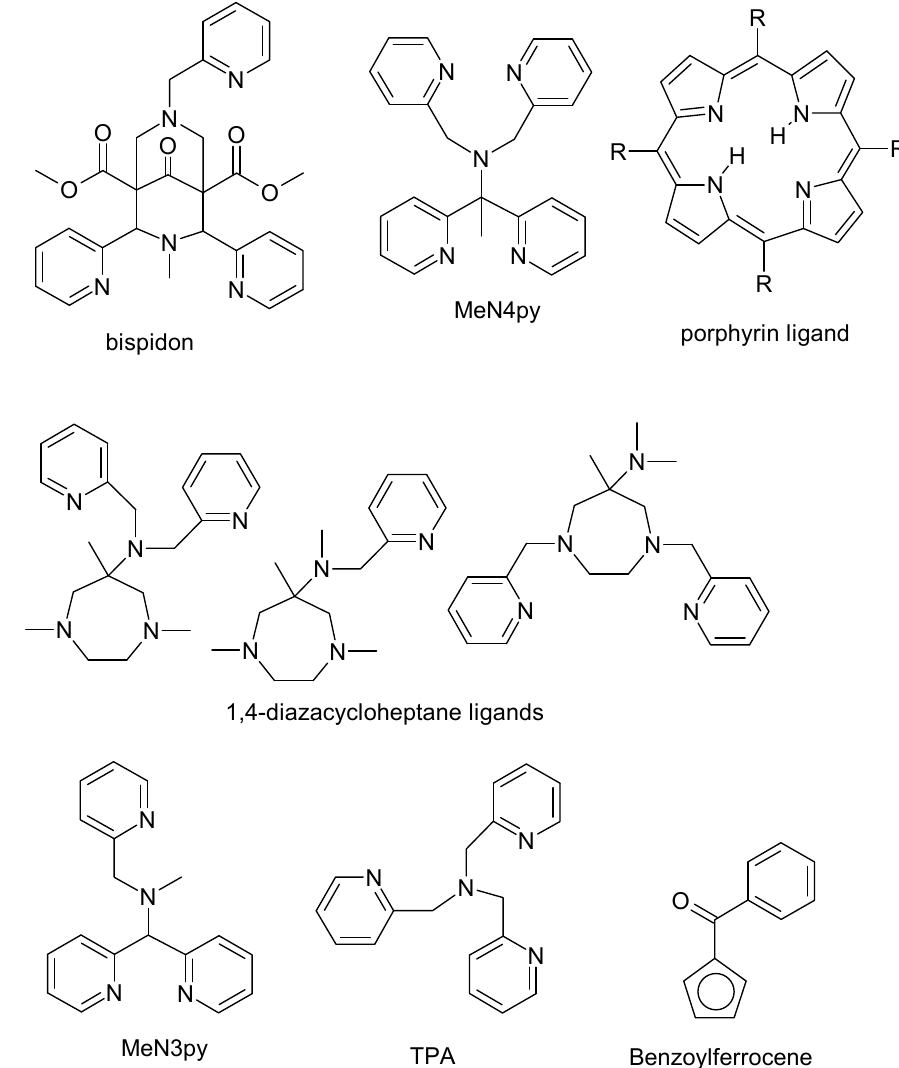
Figure 4. Ligands exhibiting paint drying activity when mixed with Fe salts or as Fe-ligand complexes as Fe-ligand complexes. Bispidon = dimethyl 3-methyl-9-oxo-2,4-di(pyridin-2-yl)-7-(pyridin-2-ylmethyl)-3,7-diazabicyclo[3.3.1]nonane-1,5-dicarboxylate, MeN4Py = N , N -bis(pyridin-2-ylmethyl)-1,1-bis(pyridine-2-yl)-1-amino-ethane, 5,10,15,20-tetrakisphenylporphyrin (R = phenyl; porphyrin ligand), 6-dimethylamino-1,4-bis(pyridine-2-ylmethyl)-6-methyl-1,4-diazacycloheptane, 1,4,6-trimethyl-6{ N -(pyridin-2-ylmethyl)- N -methylamino}-1,4-diazacycloheptane, 6,{ N , N -bis(pyridin-2-ylmethyl)amino}-1,4,6-trimethyl-1,4-diazacycloheptane (1,4-diazacycloheptane based ligands), tris(pyridin-2-ylmethyl)amine (TPA), and N-methyl-N(pyridin-2-ylmethyl)-bis(pyridin-2-yl)methylamine (MeN3py), benzoylferrocene.